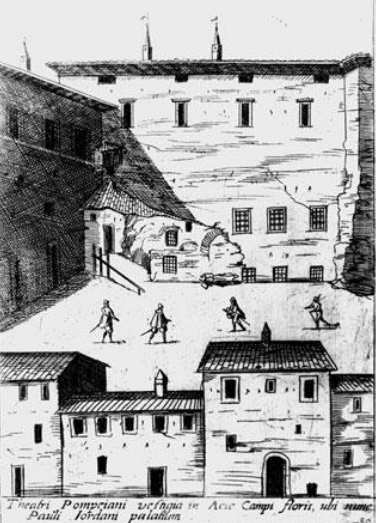
Figure 5. In this drawing by Giuseppe Maggi of 1615 we can see how the Orsini palace area appeared and